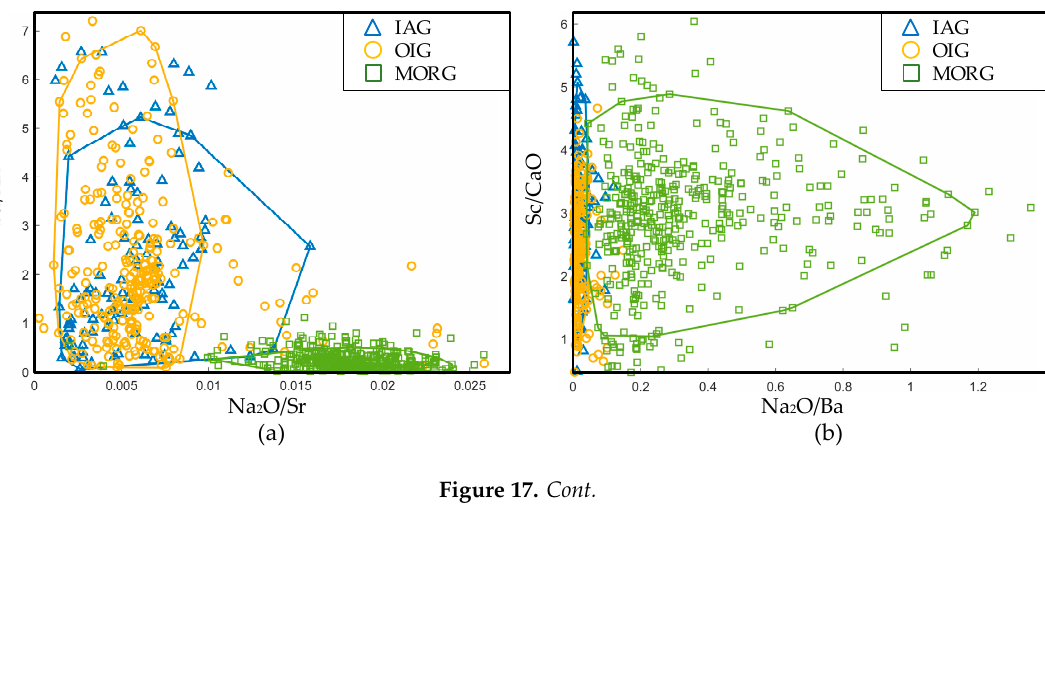
Figure 16. Statistics of the frequency of occurrence of the 26 basic elements in useful OIG and non-OIG discrimination diagrams.